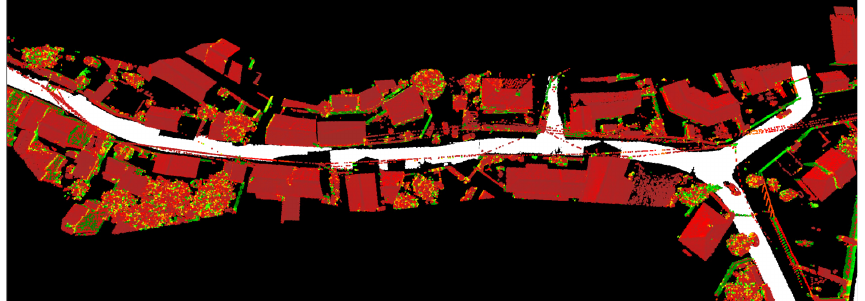
Figure 8. Verticality in the most detailed scale, KNN = 25.